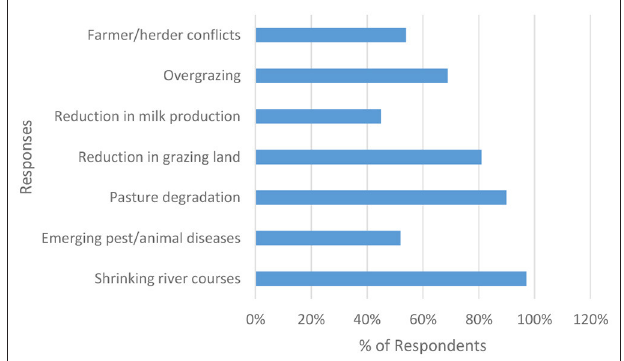
FIGURE 7 | Observed Impacts of climate variability on pastoral resources. Source: Compiled from Fieldwork Data